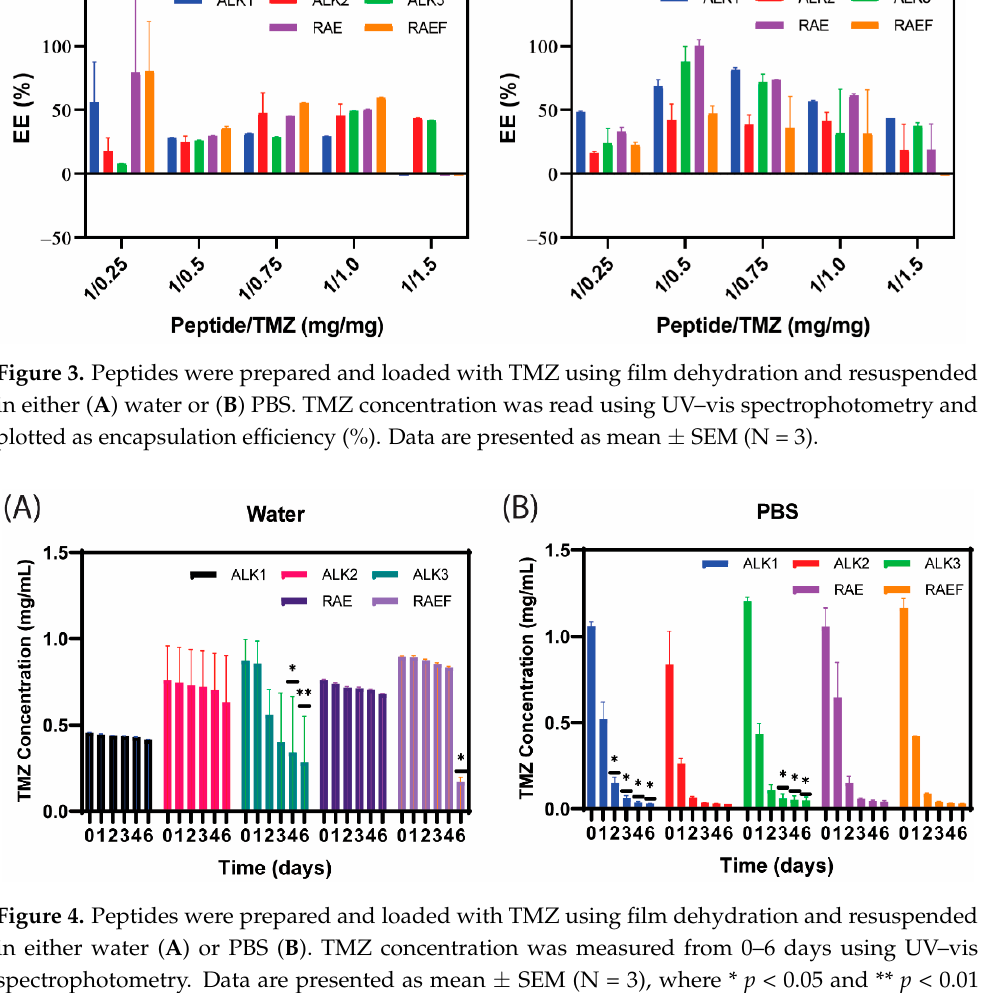
Figure 3. Peptides were prepared and loaded with TMZ using film dehydration and resuspended in either ( A ) water or ( B ) PBS. TMZ concentration was read using UV–vis spectrophotometry and plotted as encapsulation efficiency (%). Data are presented as mean ± SEM (N = 3).